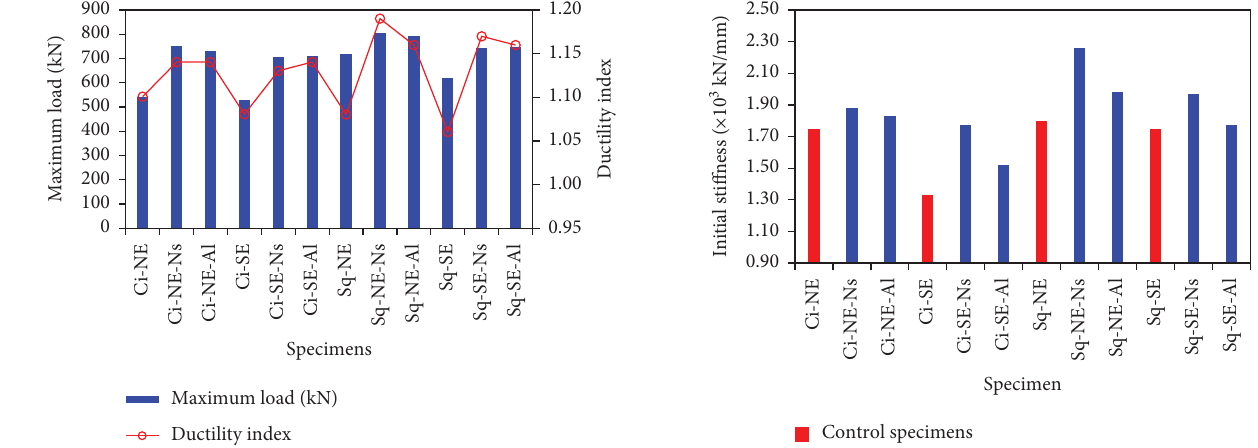
Figure 13: Simultaneous comparison of ductility-maximum load in the examined